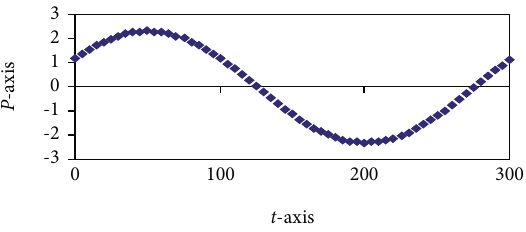
Figure 3: The numerical solution P against the time t .